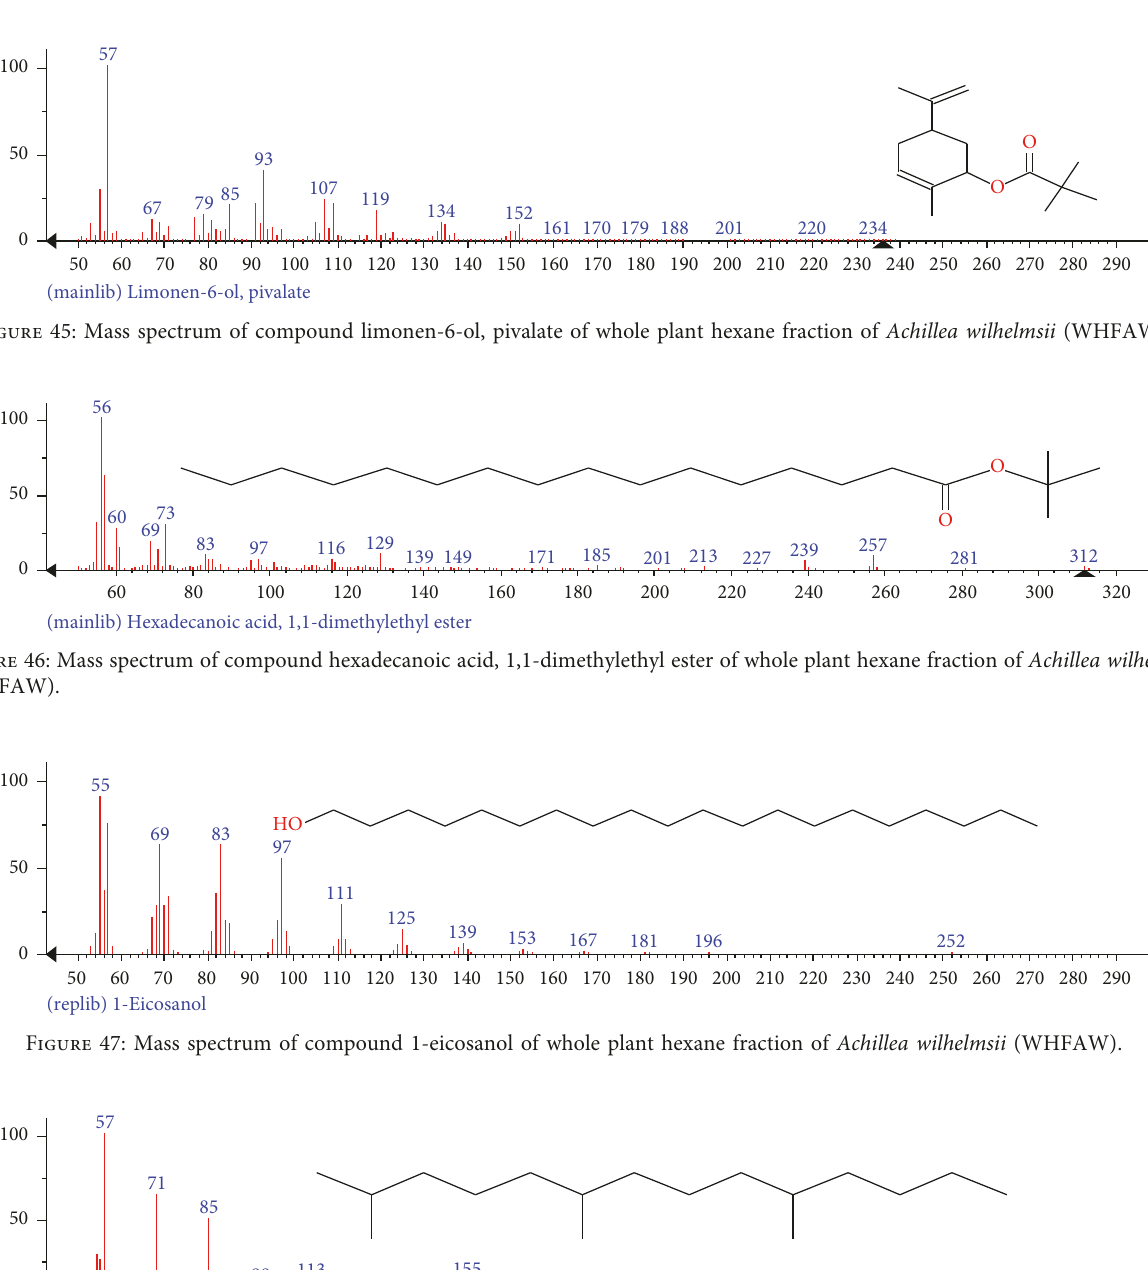
-Santonin50 60 (replib) α Figure 44: Mass spectrum of compound α -santonin of whole plant hexane fraction of Achillea wilhelmsii